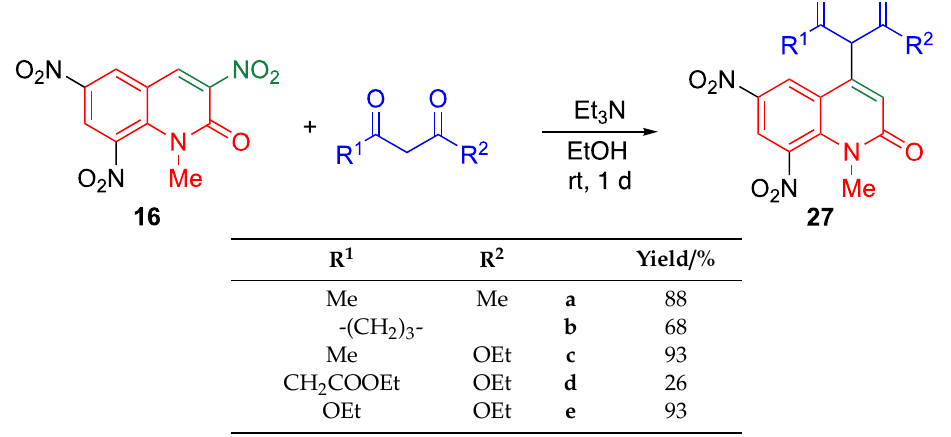
Table 6. cine -Substitution of 16 with 1,3-dicarbonyl compounds.